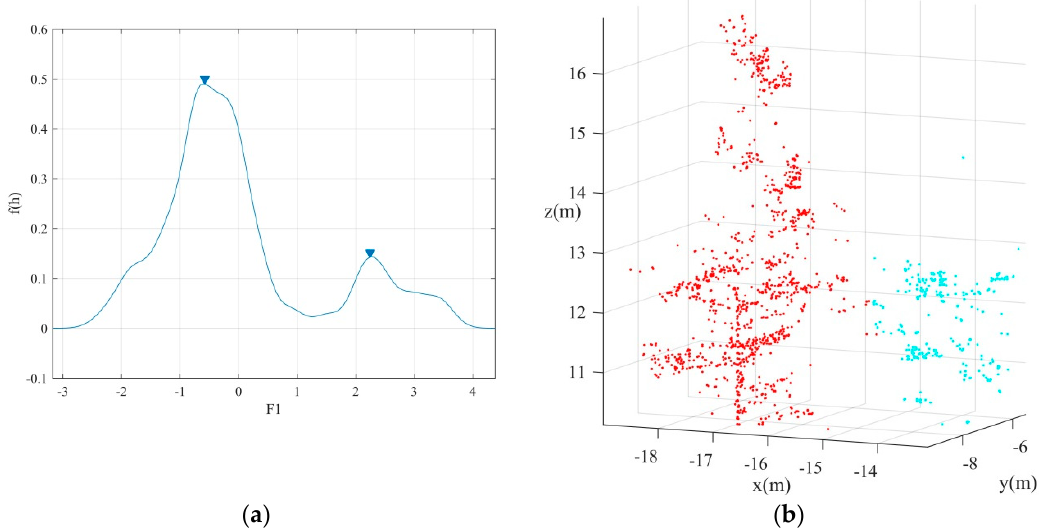
Figure 7. Canopy points extraction through Gaussian mixture model separation. ( a ) The detection the number of local maxima of the kernel density distribution curve; ( b ) the separated results of the clustered canopy points, where points with red and green colors represent two separated trees.